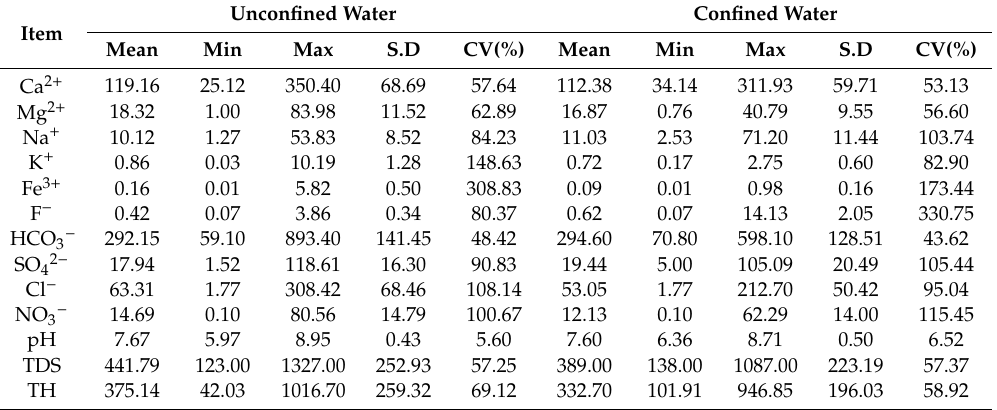
Table 1. Descriptive statistics of unconfined water and confined water hydrochemistry mg / L.